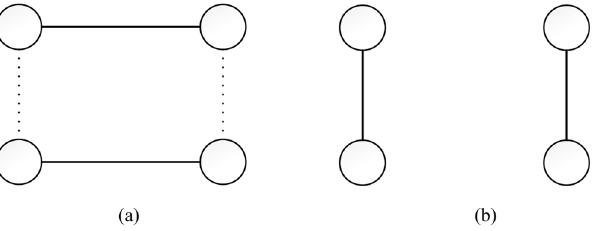
Figure 9. Structures before and after being adjusted by simple edge swapping. ( a ) Initial structure. ( b ) Structure adjusted. The solid lines mark the current existing edges, while the dotted lines mark the targeted edges to be constructed.